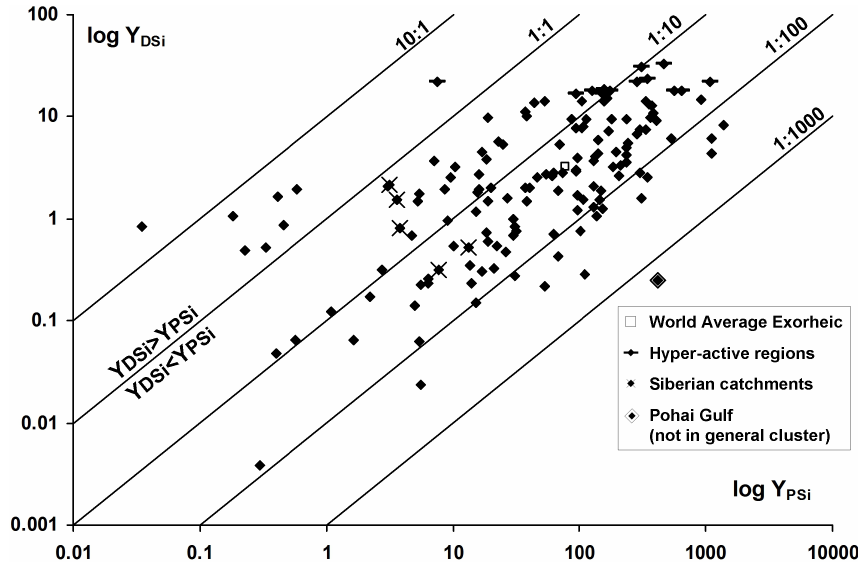
Fig. 3. General relation between dissolved ( Y DSi ) and particulate ( Y PSi ) silica yields in the 140 coastal catchments and in the global budget. Y DSi and Y PSi in tSiO 2 km − 2 y − 1 , log